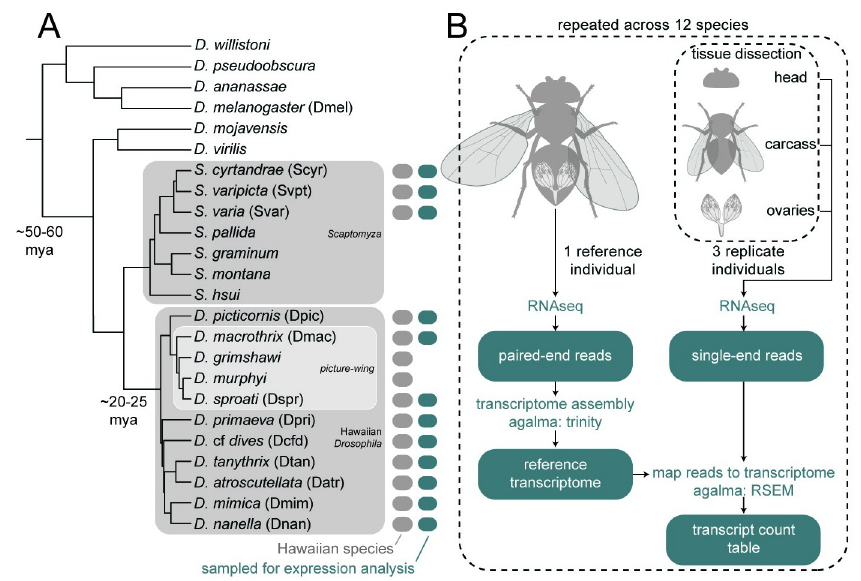
Fig 1. Phylogeny of species and RNA sampling strategy. A, Twelve species of Hawaiian Drosophilidae flies were collected in the wild and processed for RNA sequencing. The twelve reference transcriptomes assembled from these species were combined with twelve published genomes to generate the phylogeny shown here (originally published in Church and Extavour, 2021 [44]). Divergence times estimated by Russo and colleagues, 2013 [45]. Three clades within the group are highlighted: the genus Scaptomyza , nested within the paraphyletic genus Drosophila ; the Hawaiian Drosophila , which, along with Scaptomyza , make up the Hawaiian Drosophilidae; and the well-known picture-wing clade. Adjacent to tip labels are four letter species codes used throughout the manuscript. B, The experimental design used to generate the data in this manuscript. When sufficient specimens were available per species, one whole individual was used as a reference and three whole individuals were dissected into three separate tissues: the head, ovaries, and all remaining material (carcass). Reference individuals were sequenced to generate paired-end RNA reads and dissected tissues were sequenced to generate single-end RNA reads. Tissue libraries were then mapped to the assembled reference to quantify transcript expression. Teal boxes indicate data files. Dashed-line boxes indicate a repeated step.